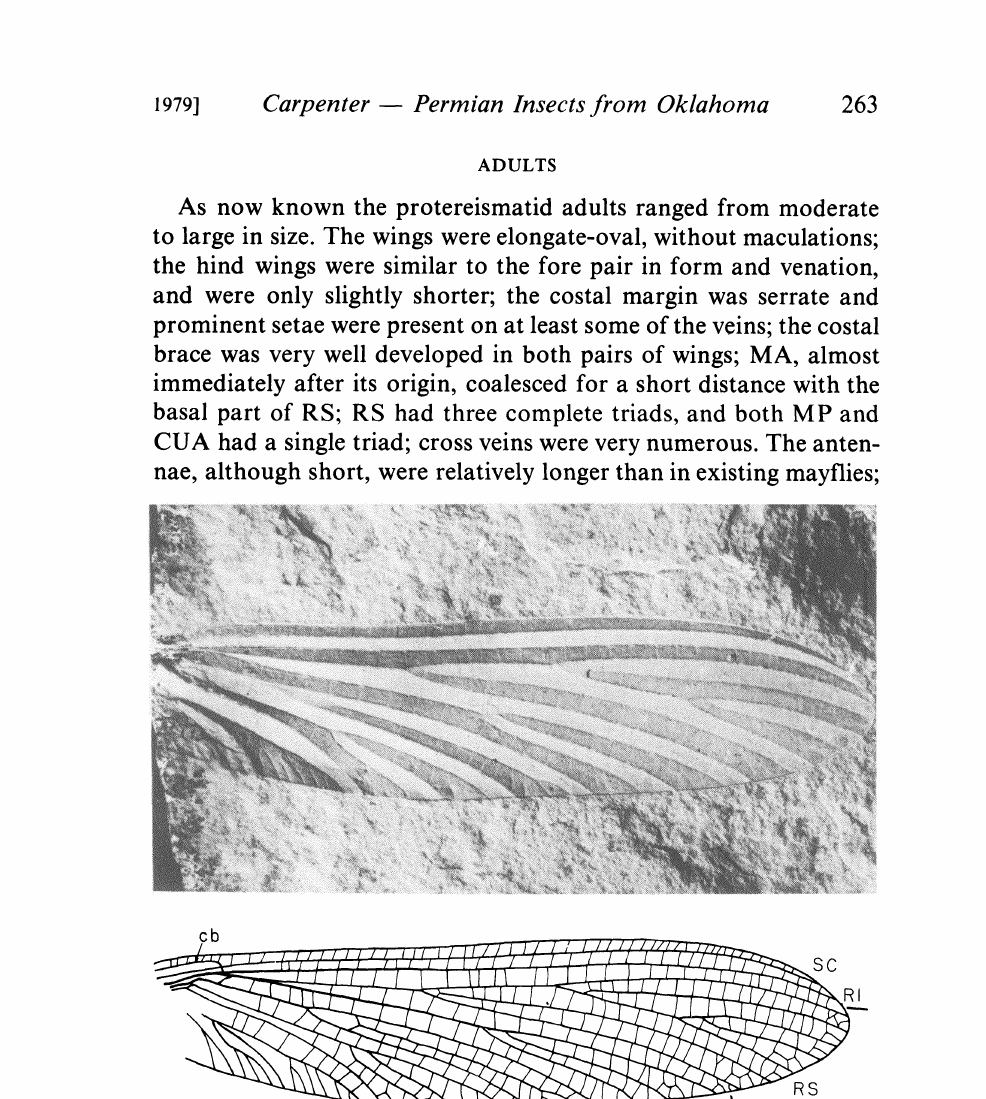
(above). Protereisma directum, n.sp. Photograph of holotype (fore wing), MCZ 5180a, Permian of Oklahoma. Length of wing, 26 mm. Figure 2 (below). Protereisma directum, n.sp. Drawing of fore wing (holotype). SC, subcosta; RI, radius; RS, radial sector; MA, anterior media; MP, posterior media; CUA, anterior cubitus; CUP, posterior cubitus; cb, costal brace. The con- vexities and concavities of the veins are shown in figure